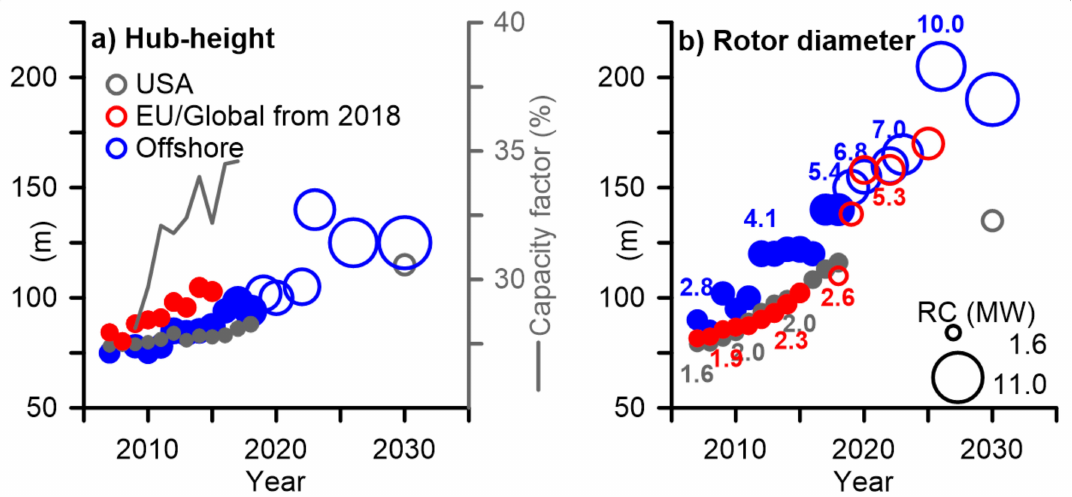
Figure 1. ( a ) Mean hub-height ( H , in m) and ( b ) rotor diameter ( D , in m) and rated capacity (RC, in megawatts (MW), symbol size) of wind turbines (WT) installed in each calendar year in the EU to 2015, and USA and o ff shore to 2018 [3–5]. WT dimensions from 2019 onwards are projections shown by the open symbols [6–8]. The line in the left panel shows annual mean capacity factors in the US from 2008 to 2015